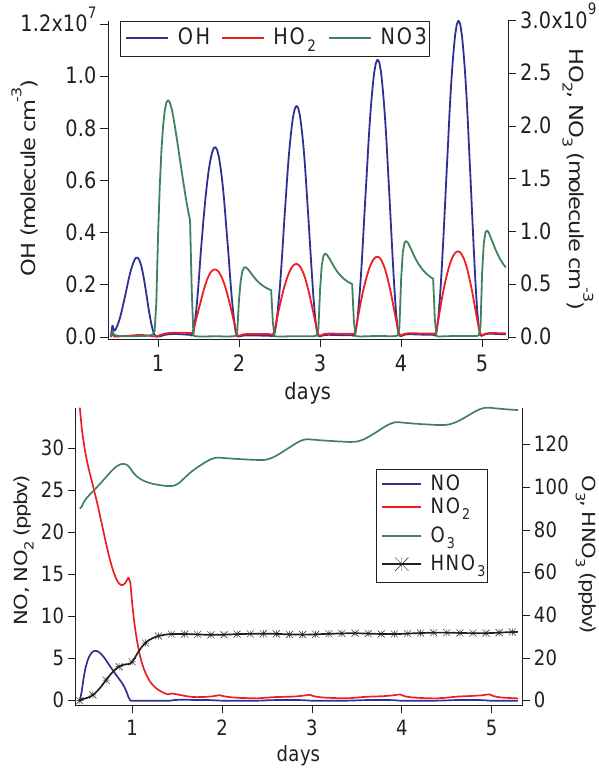
Fig. 1. Modelled concentrations of radicals (a) , O 3 , NO x and HNO 3 (b)